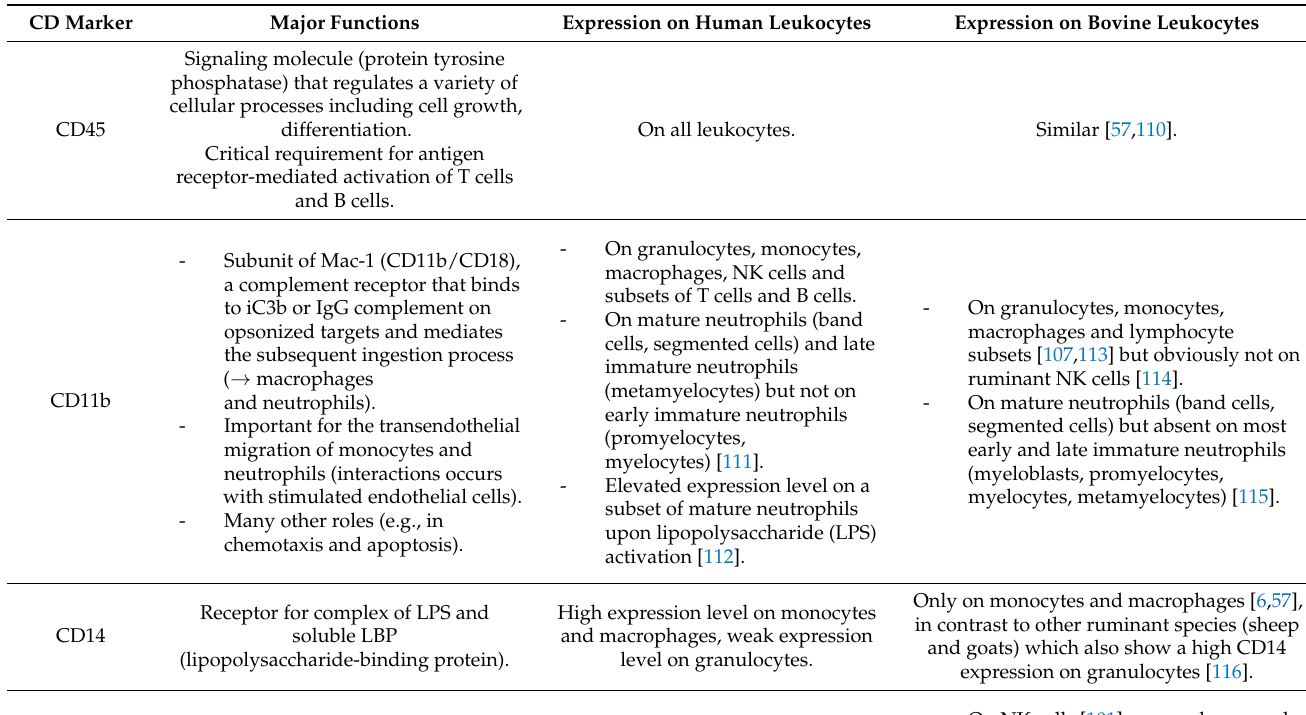
Table 5. Pan-leukocyte marker CD45 and differences in the surface marker expression of hu- man and bovine myeloid immune cells and lymphocytes. Apart from the indicated references, References [98,99] were investigated to collect the presented data. CD = cluster of